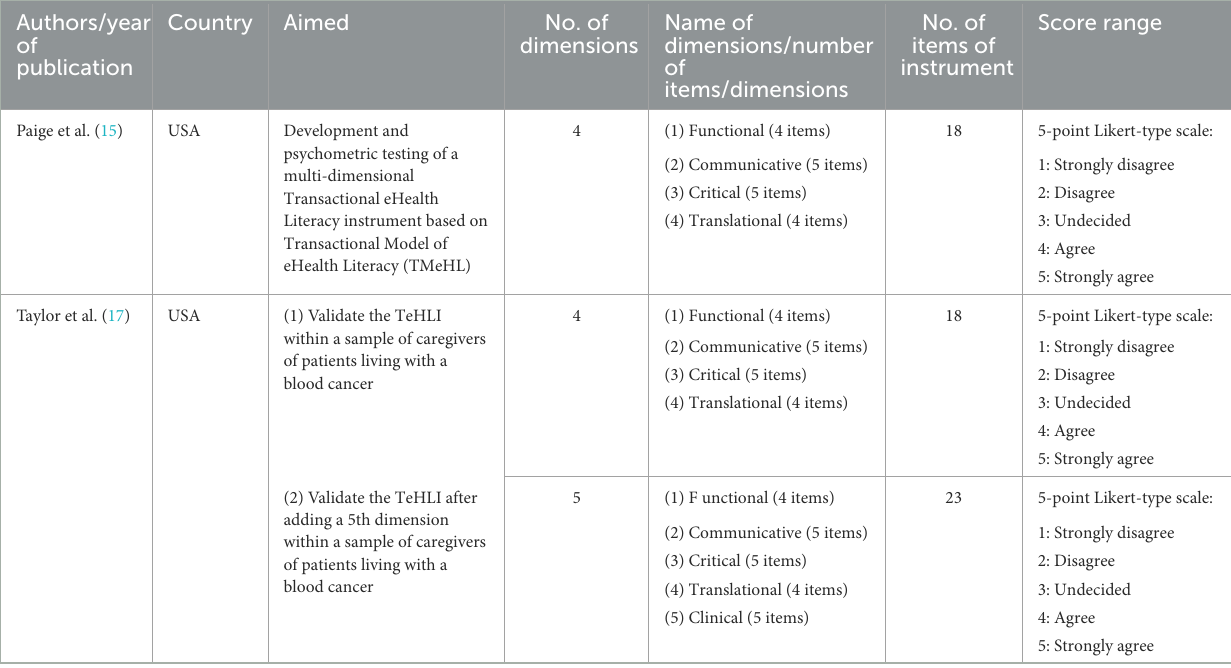
TABLE 1 The characteristics of transactional ehealth literacy instrument (TeHLI). Authors/year